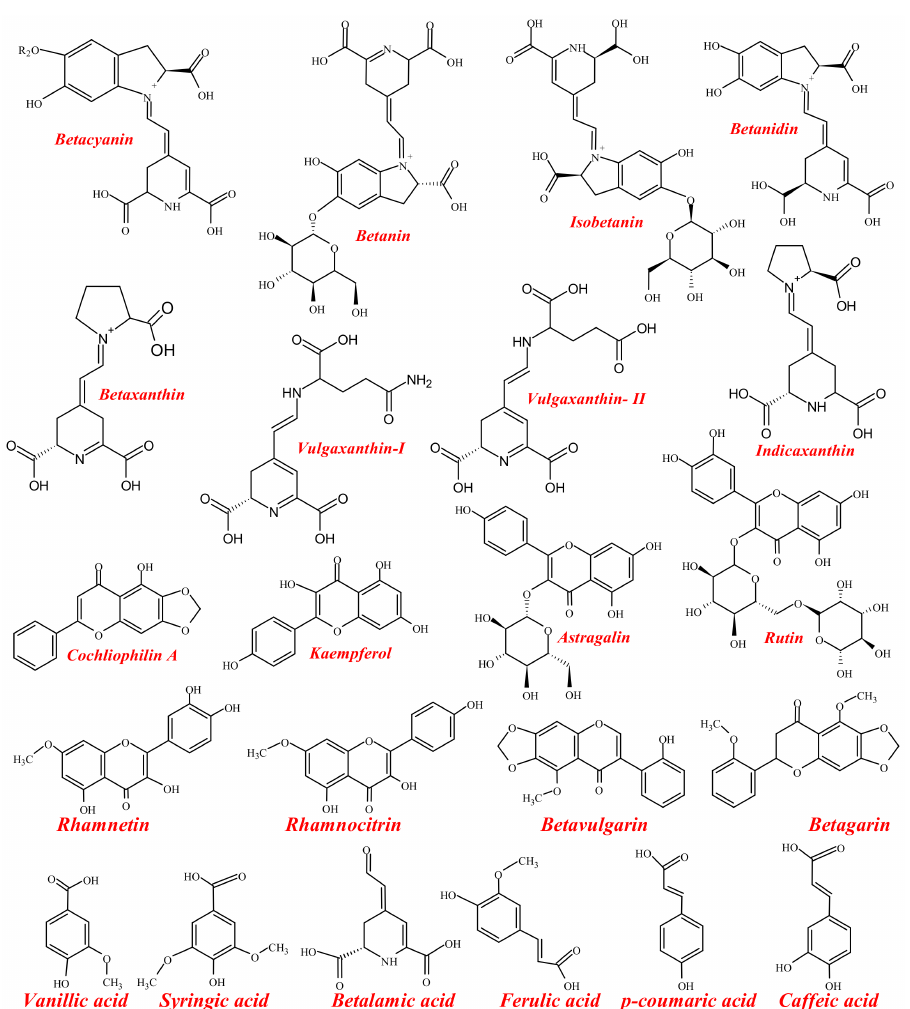
Figure 1. The systematic diagram is showing major phytochemicals present in the Beta vulgaris